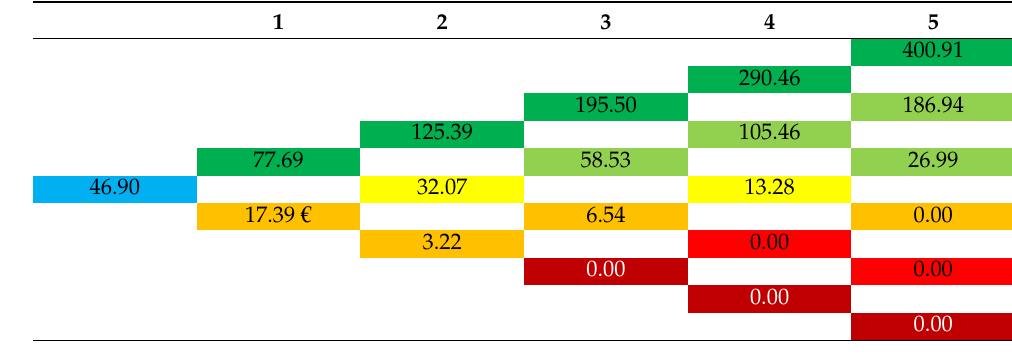
Table 6. Binominal option pricing model. Real options lattice: a value of Amazon tacit synergies of the acquisition of Souq.com (in USD